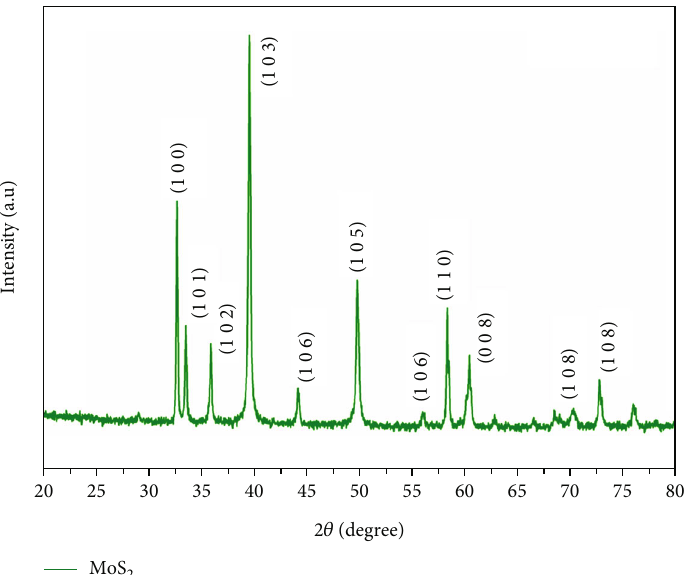
Figure 2: X-ray di ff raction pattern of synthesized MoS